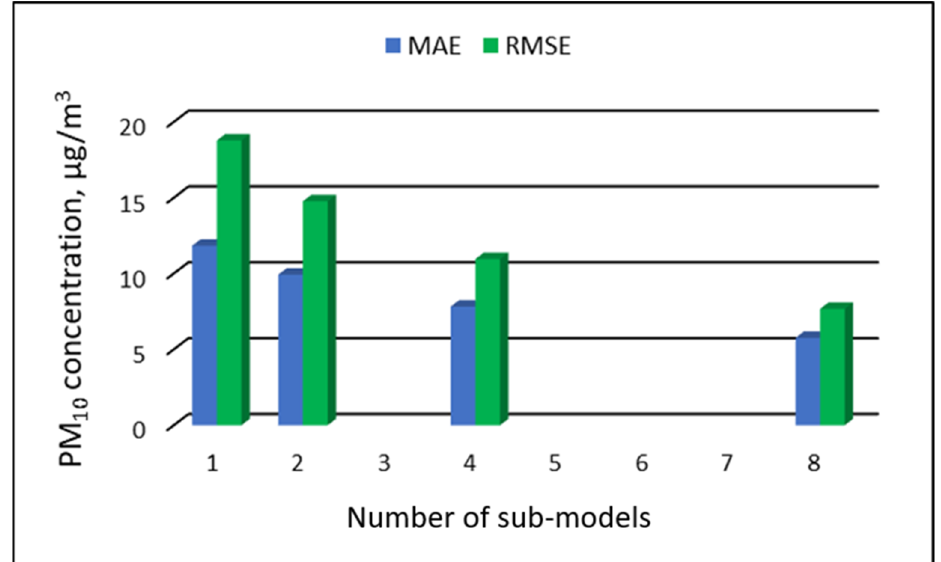
Table 22. Values of approximation errors of PM 10 concentrations in RVS models, Z ł oty Potok 2011– 2016.